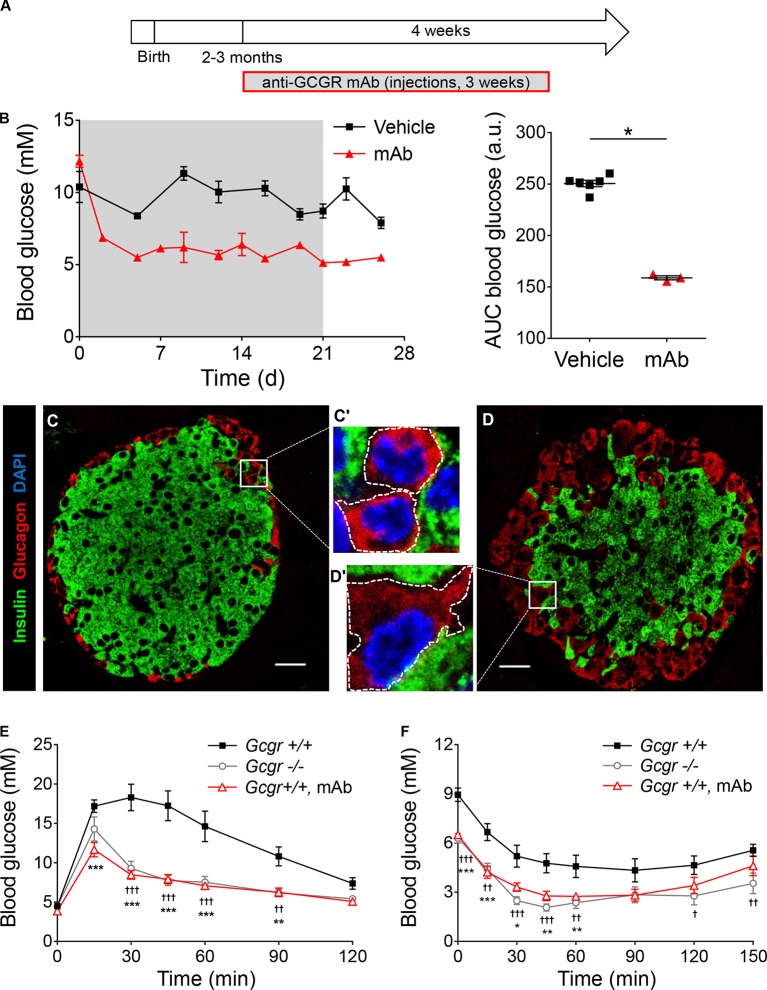
Anti-GCGR mAb administration recapitulates the metabolic and cellular phenotypes of Gcgr-/- mice.(A) Experimental design. 9 mg/kg anti-GCGR mAb was injected i.p. 3 times per week for 3 weeks in C57BL/6 animals. (B) Left: Random fed glycemia of vehicle- (black squares) or mAb-treated males (red triangles). The grey area indicates the period of antibody treatment. Right: Area under the glycemia curves. *p<0.05; Mann-Whitney U test. C and D. Confocal images of pancreatic islet sections from vehicle- (C) and mAb-treated (D) males. α-cell hyperplasia and hypertrophy (compare C’ and D’, the dashed lines represent the cell perimeters) are observed in islets from mAb-treated mice. Scale bars: 20 μm. E and F. Intraperitoneal glucose tolerance test (E) and insulin tolerance test (F) performed in Gcgr+/+ (black squares, N=9), Gcgr-/- (grey circles, N=10), and mAb pre-treated Gcgr+/+ (red triangles, N=10) males. *p<0.05; **p<0.01; ***p<0.001; Gcgr+/+ versus mAb-treated Gcgr+/+ mice. †, p<0.05; ††, p<0.01; †††, p<0.001; Gcgr+/+ versus Gcgr-/- mice; two-way ANOVA. The difference between Gcgr-/- and mAb-treated Gcgr+/+ mice is not significant.